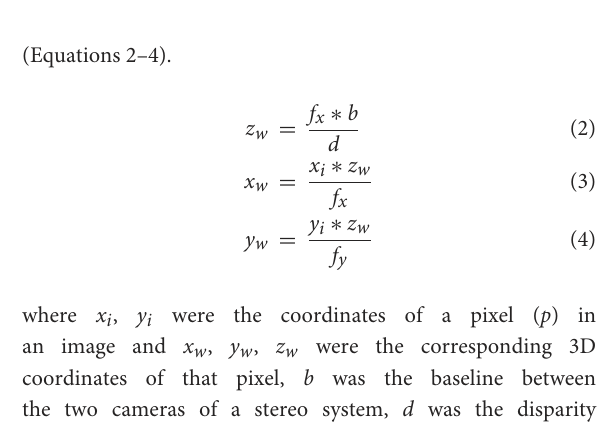
green, blue (RGB) color space into the hue, saturation, value (HSV) space where illumination effects on color appearance could be further isolated. The color filter was designed to identify